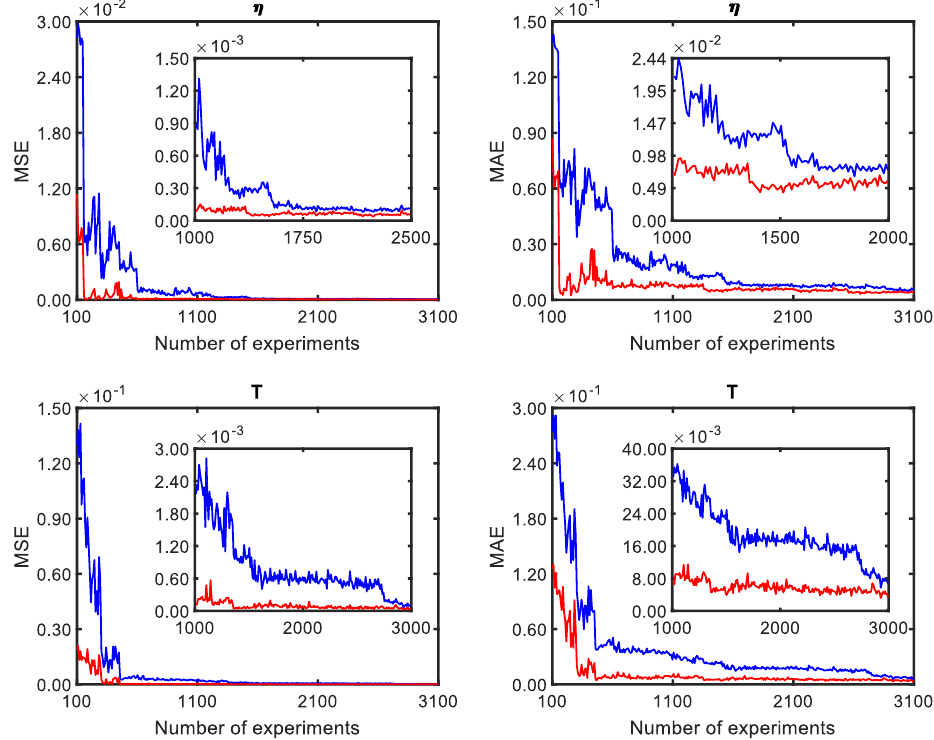
Figure 10. Training performance as a function of